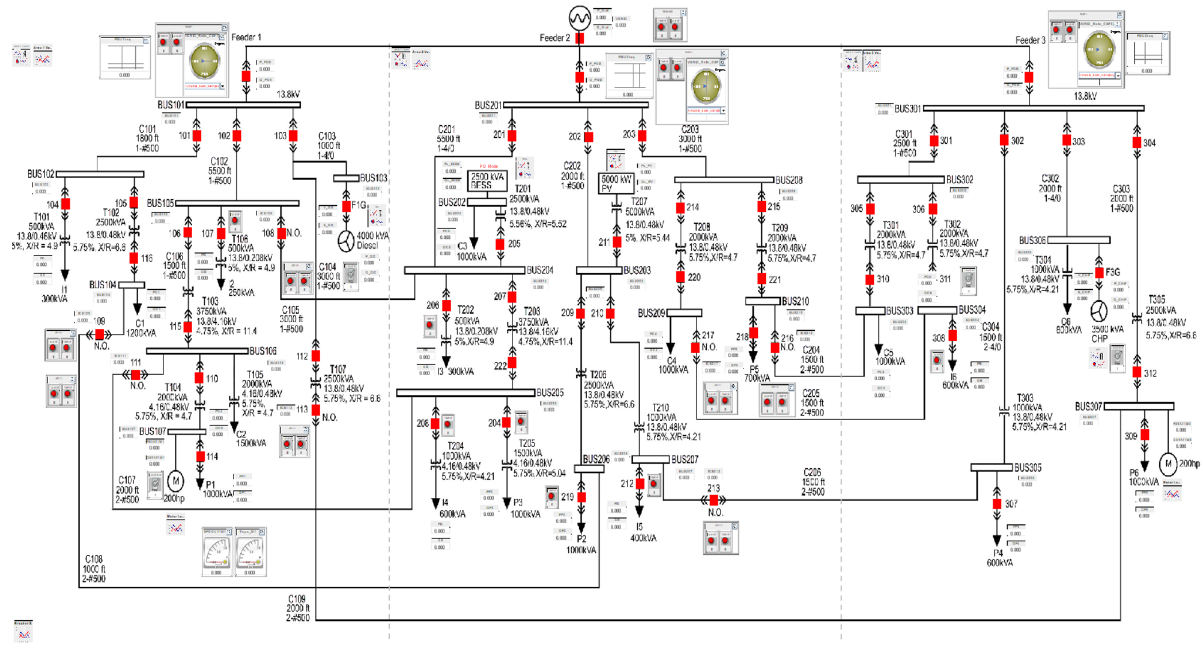
Figure 7. Runtime single line diagram of Banshee